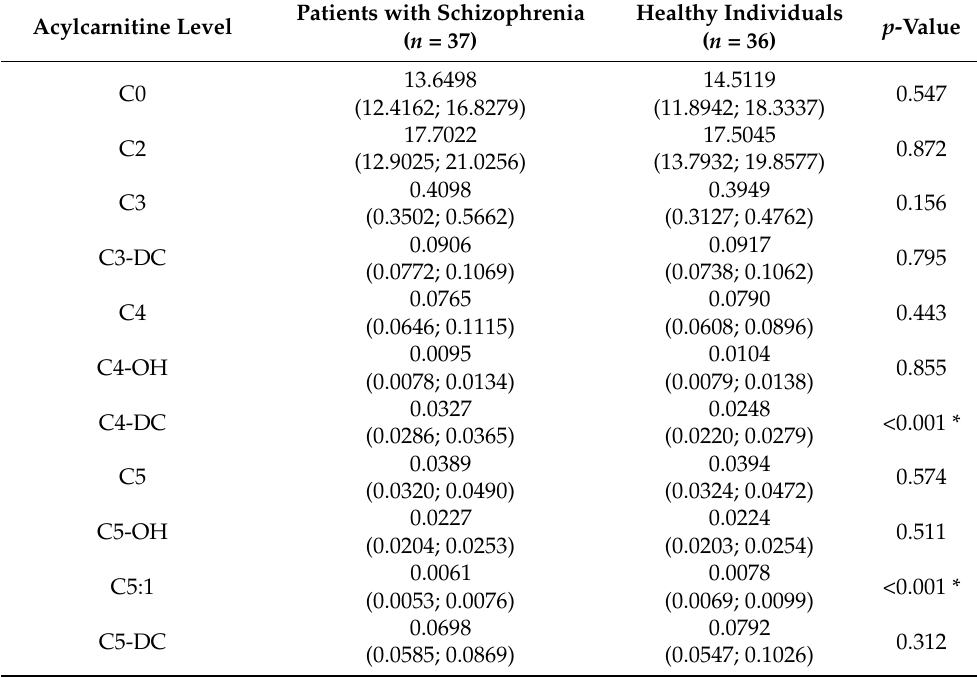
Table 3. The concentration of acylcarnitine ( µ mol/L) in the blood serum of patients with schizophre- nia and healthy individuals, Me (Q1;